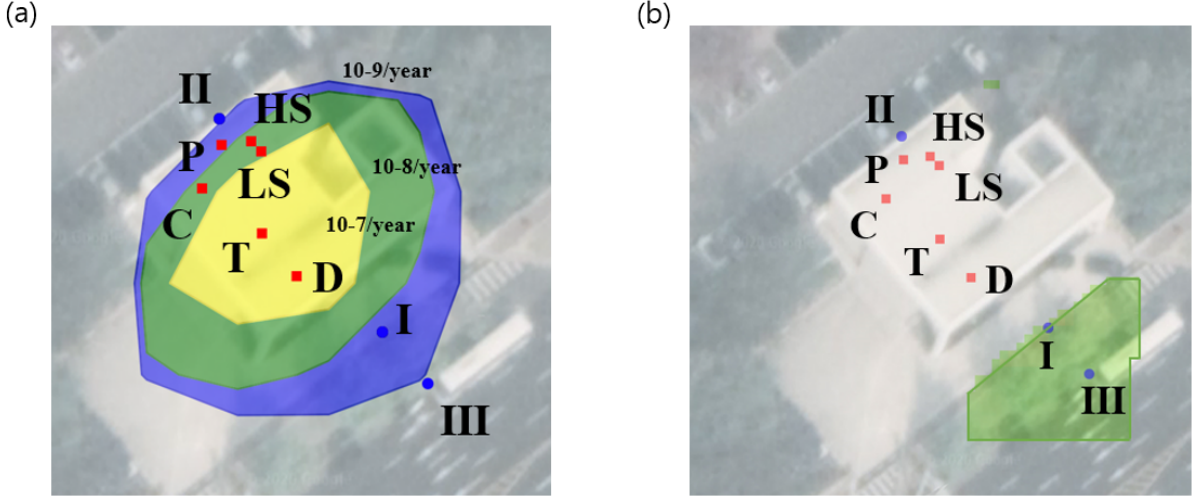
Figure 4. ( a ) Analysis of individual risk when applying passive IPLs and ( b ) contribution of individual risk in each place with passive IPLs.